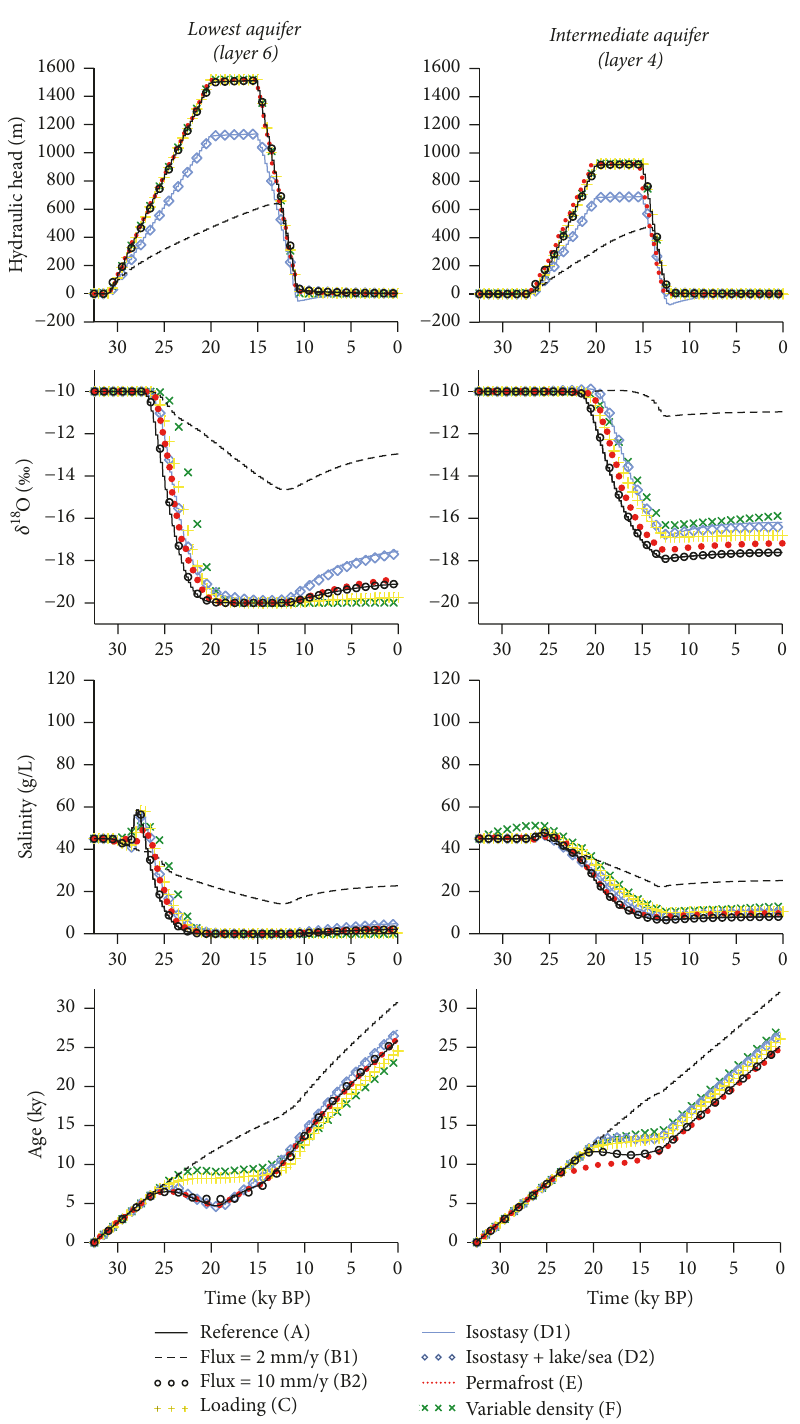
Figure3: Evolutionof hydraulichead, 𝛿 18 O, salinity, and groundwater age inall simulations. Data aresampled in thelowest aquifer at location “55 km, − 300 m” and in the intermediate aquifer at location “175km, − 300